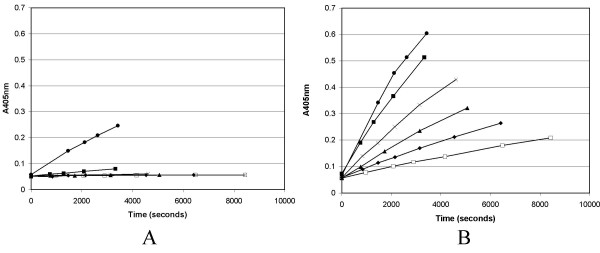
Increases in proteinase K activity with and without heating. Proteinase K variants were tested from triplicate independent cultures for activity after heating at 68°C for different times: unheated (circles), 2.5 minutes (squares), 5 minutes (crosses), 7.5 minutes (triangles), 10 minutes (diamonds) and 15 minutes (open squares). A: absorbance at 405 nm of substrate incubated with wild type proteinase K, B: absorbance at 405 nm of substrate incubated with variant 3–9.